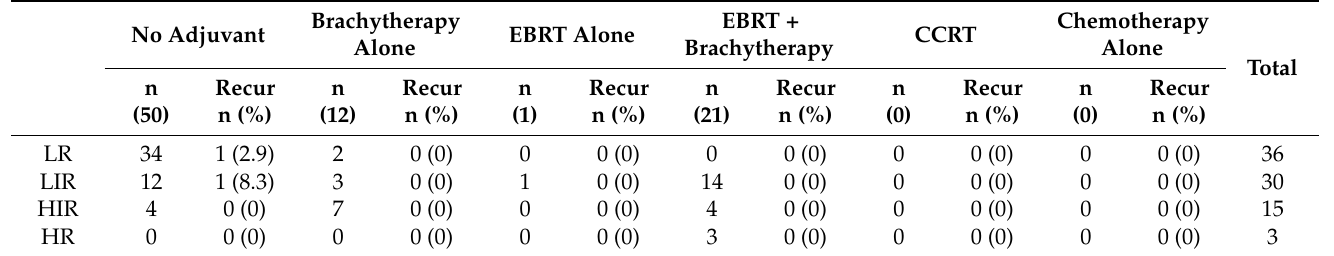
Table 3. Comparison of adjuvant treatments, and recurrences by Gynaecology Oncology Group (GOG) for Premenopausal group among women with stage 1 endometrial cancer in Hospital Melaka from 2001–2020.